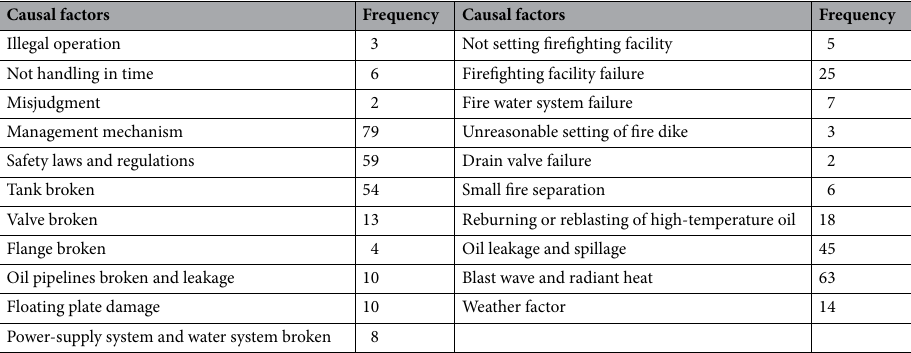
Table 1. Statistics on causal factors and frequencies. Frequency refers to the occurrence times of each causal factor in the 122 accident cases.